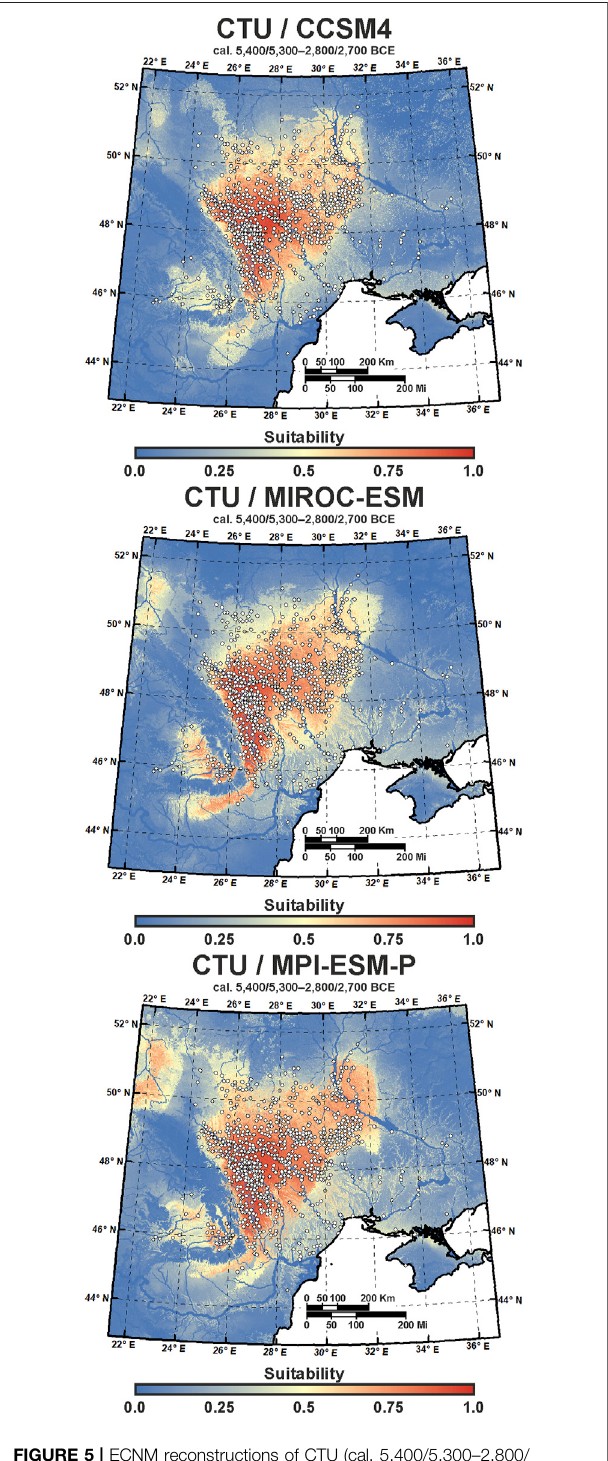
FIGURE 5 | ECNM reconstructions of CTU (cal. 5,400/5,300 – 2,800/ 2,700 BCE) using terrain variables and mid-Holocene CCSM4, MIROC-ESM, andMPI-ESM-Pbioclimaticvariables;colorsrangefromblue(0)toyellow(0.5) and to red (1), or low(0) to high (1) suitability, respectively; the whitedots represent CTU sites used for niche